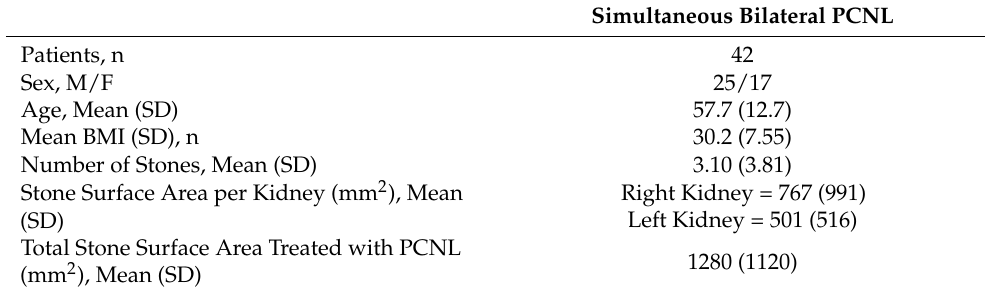
Table 1. Patient demographic and target stone size.